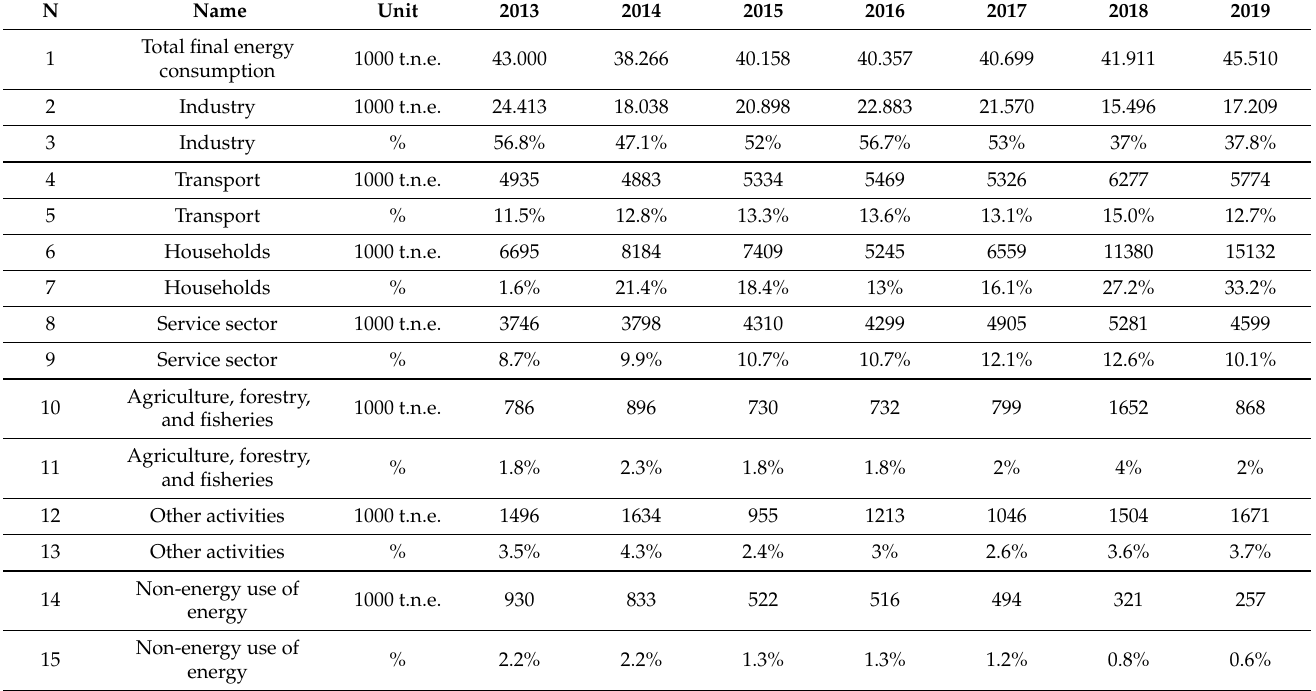
Table 4. Final energy consumption of the Republic of Kazakhstan for 2013–2019. Note: developed by the authors according to the data of the Bureau of National Statistics of the Agency for Strategic Planning and Reforms of the Republic of Kazakhstan. (Bureau of National Statistics of the Agency for Strategic Planning and Reforms of the Republic of Kazakhstan,